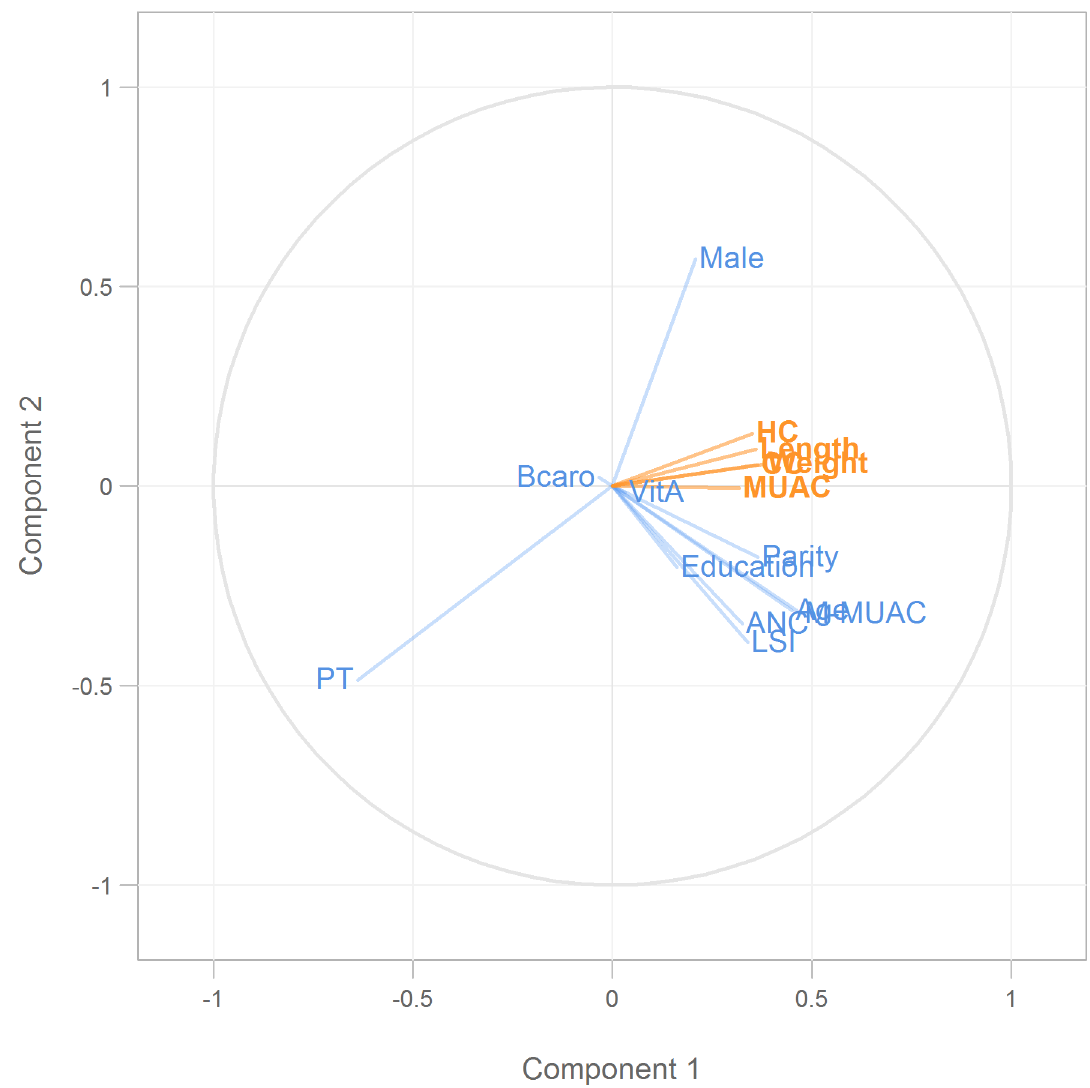
Fig 4. Correlation plot for the first two components. Orange color indicatingthe weights of dependentvariables (birth size variables: weight, length, head (HC), chest (CC) and arm (MUAC) circumferences) and the blue color indicating the weights of the predictors (maternal and infant factors: maternalage, parity, education,MUAC, vitamin A sup. (VitA) and β -carotene sup. (Bcaro), living standardindex (LSI), antenatalcare visit (ANC), preterm delivery (PT), and infant’s sex (Male)).